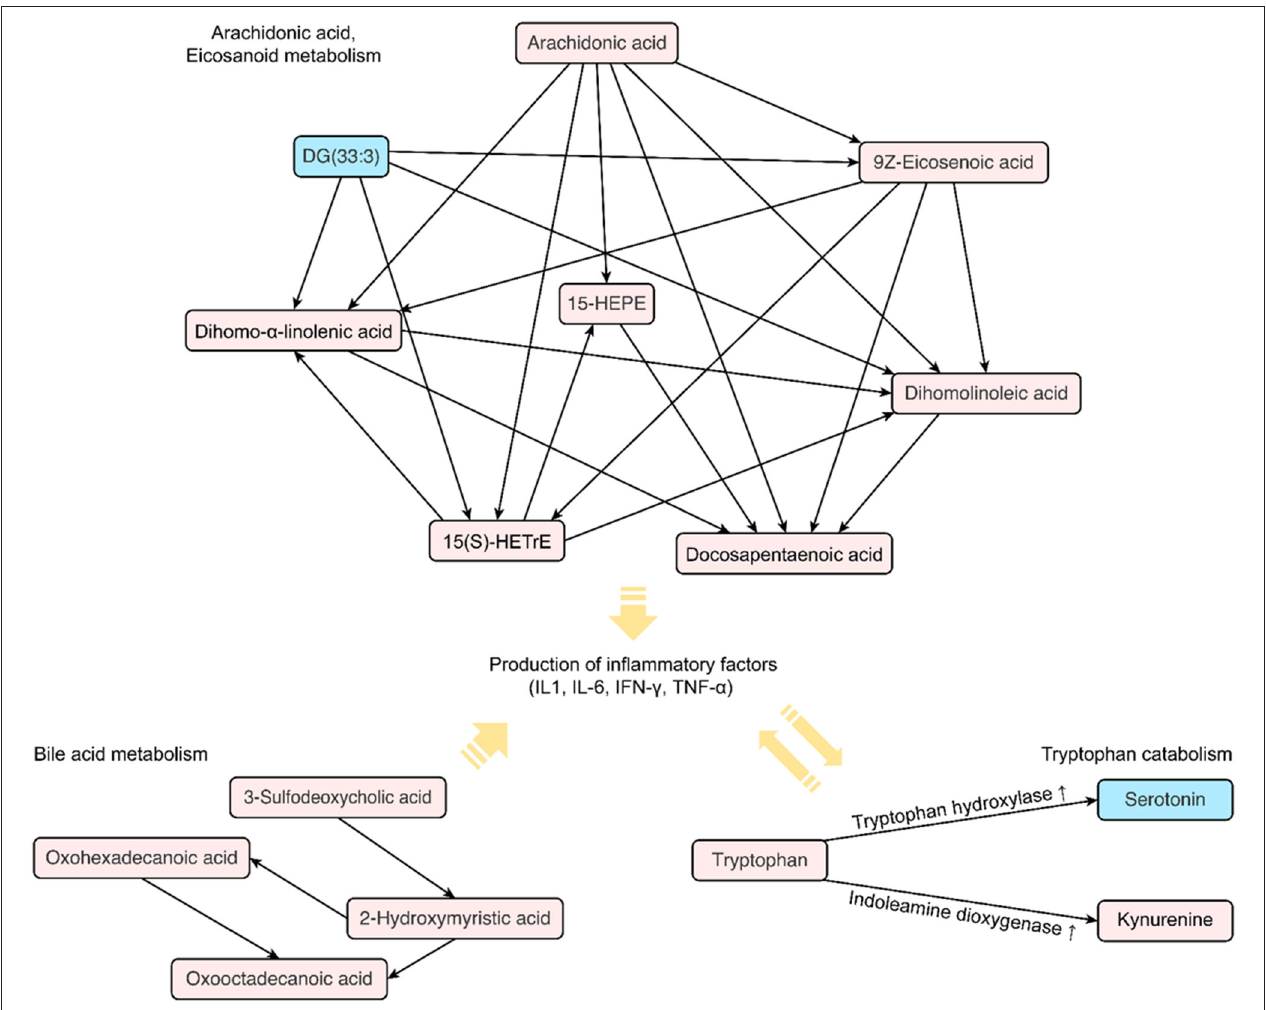
FIGURE 5 | Distinct metabolic pathways identified in patients with COPD following a TB infection. The diagram shows a map of metabolic biomarkers exclusively selected in patients with TB-induced COPD. The red square indicates increased levels of metabolites in the serum of patients with COPD, whereas blue indicates decreased levels. The arrow indicates the possible direction of the metabolic pathway based on the KEGG